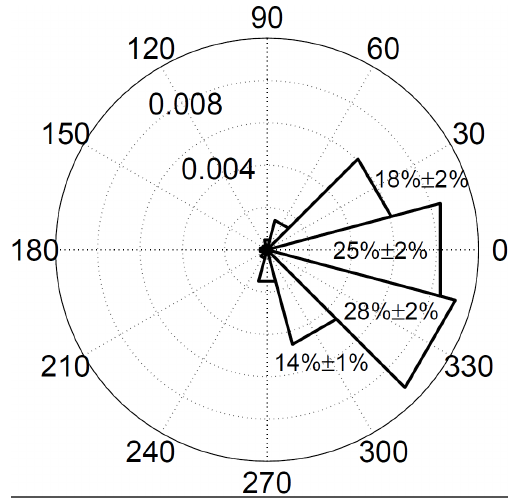
Figure 4. Probability density function of wind direction at 49.25 ◦ S, 71.25 ◦ E, just to the east of Kerguelen. The pdf is represented as a rose histogram, appropriately normalized so that the representation is not dependent on bin width or sample size. A total of 2522 daily wind observations are used. Also indicated are the percentages of days on which winds fall into each of the four most common direc- tional bins, with 2 σ uncertainties determined from a 100-realization bootstrap with